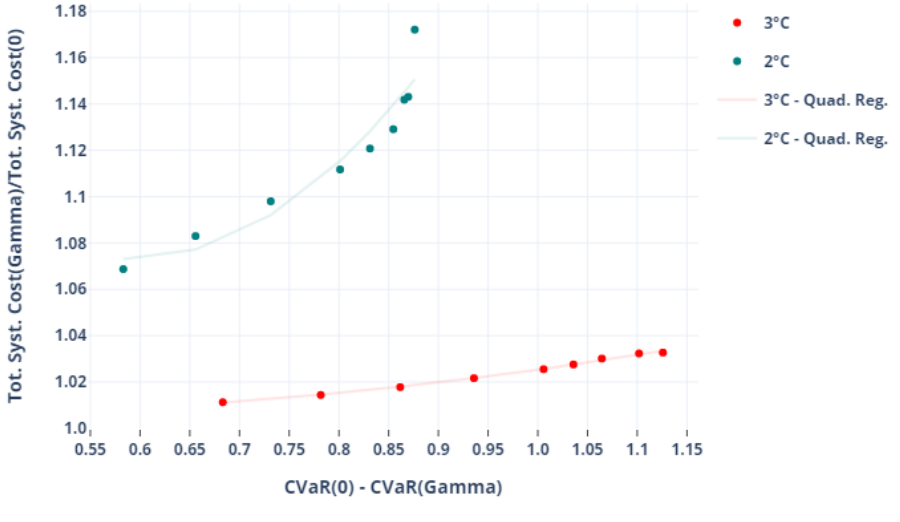
Figure 5. Costs of insurance (TSC: Total System